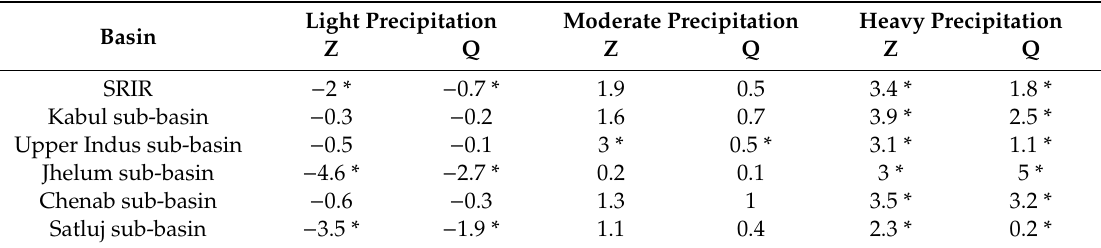
Table 2. Results of MK test statistics (Z) and Sen’s slope (Q) for di ff erent precipitation classes.